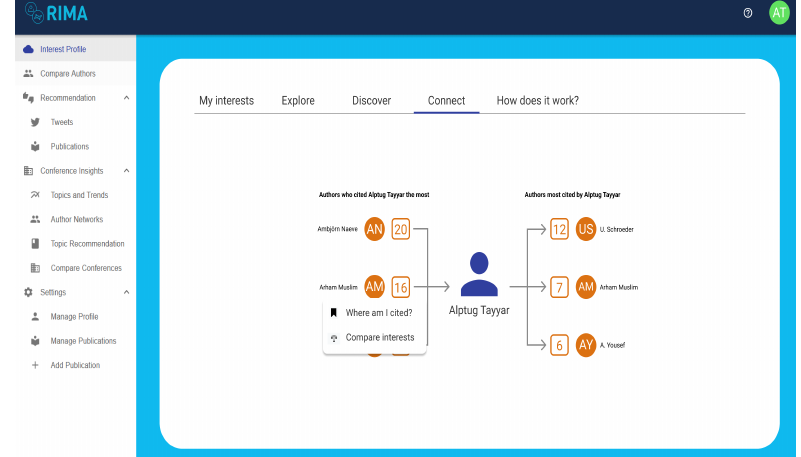
Figure 21. Influence diagram.